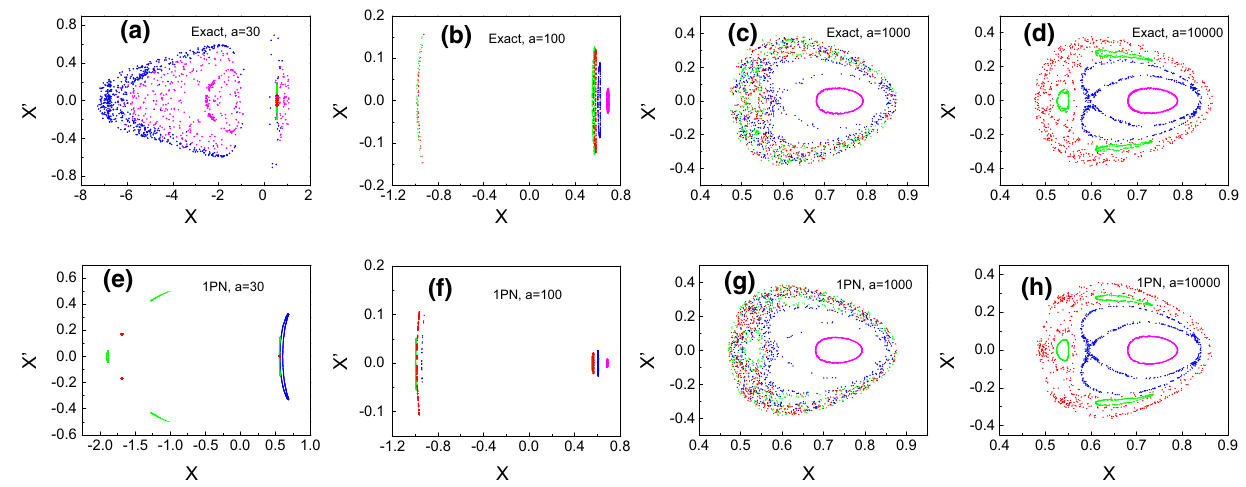
Fig. 13 Poincaré surface sections of Orbit 1 (green), Orbit 2 (red), Orbit 3 (blue), and Orbit 4 (magenta) respectively in the exact system (12) and the 1PN truncated system (16)–(17) with different a